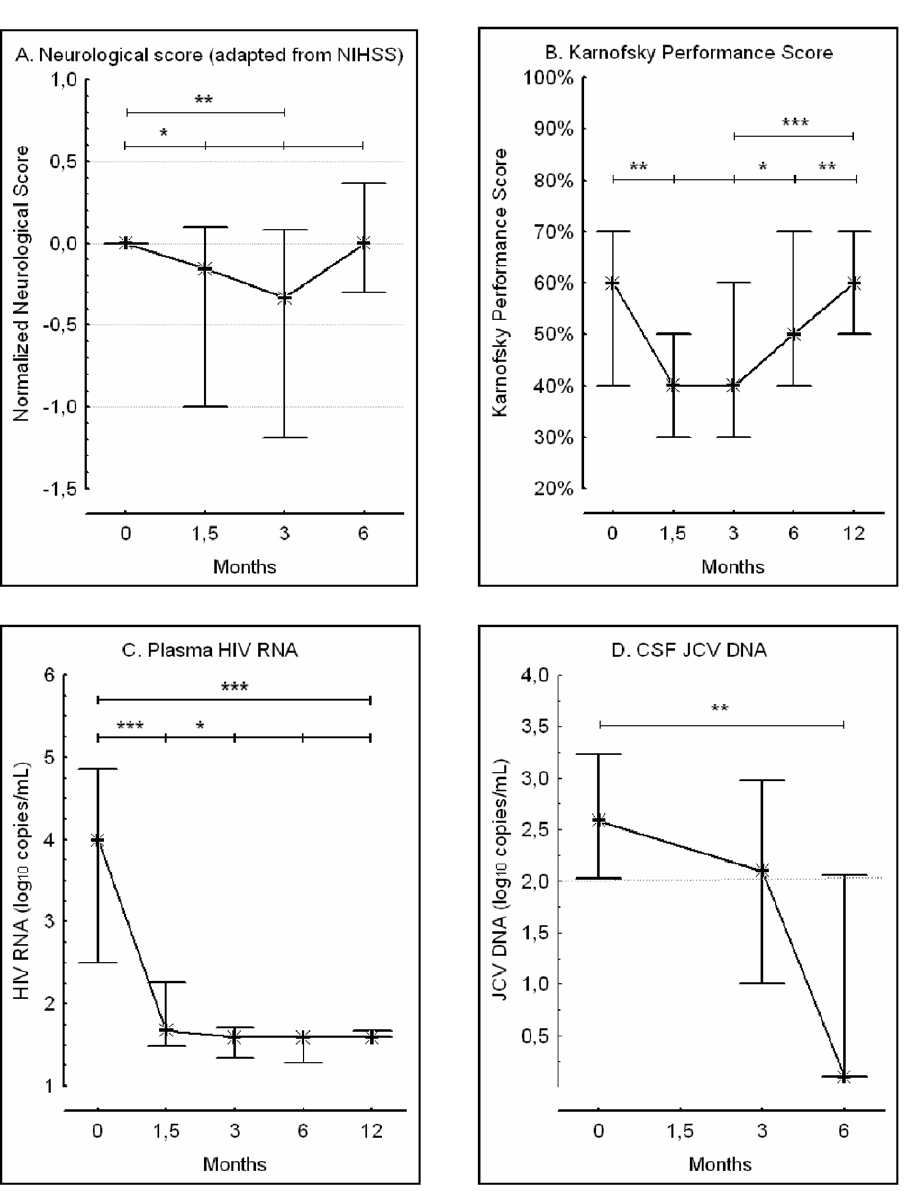
Figure 2.Time course of clinical and virological parameters. Biphasic course of a normalized neurological score from baseline to M6 (panel A) and of the Karnofsky performance score from baseline to M12 (panel B). Early and sustained plasma HIV RNA response from baseline to M12 on early five-drug antiretroviral therapy (panel C). Significant reduction in JCV DNA in CSF at M6 (panel D). Whiskers represent medians and interquartiles. Wilcoxon’s signed-rank test : * P , 0.05, ** P , 0.01, *** P ,